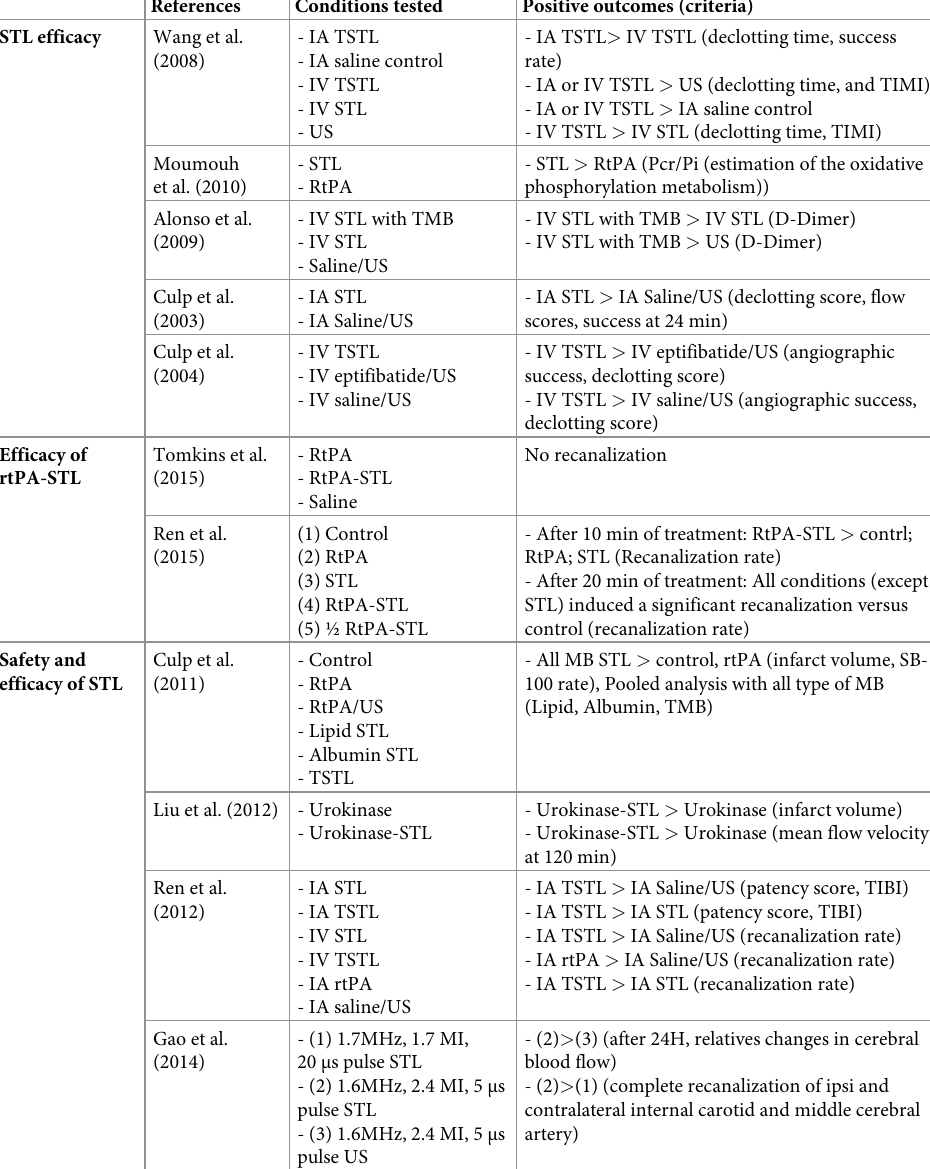
Table 6. Conditions undergoing testing and main outcomes (p < 0.05) of the 16